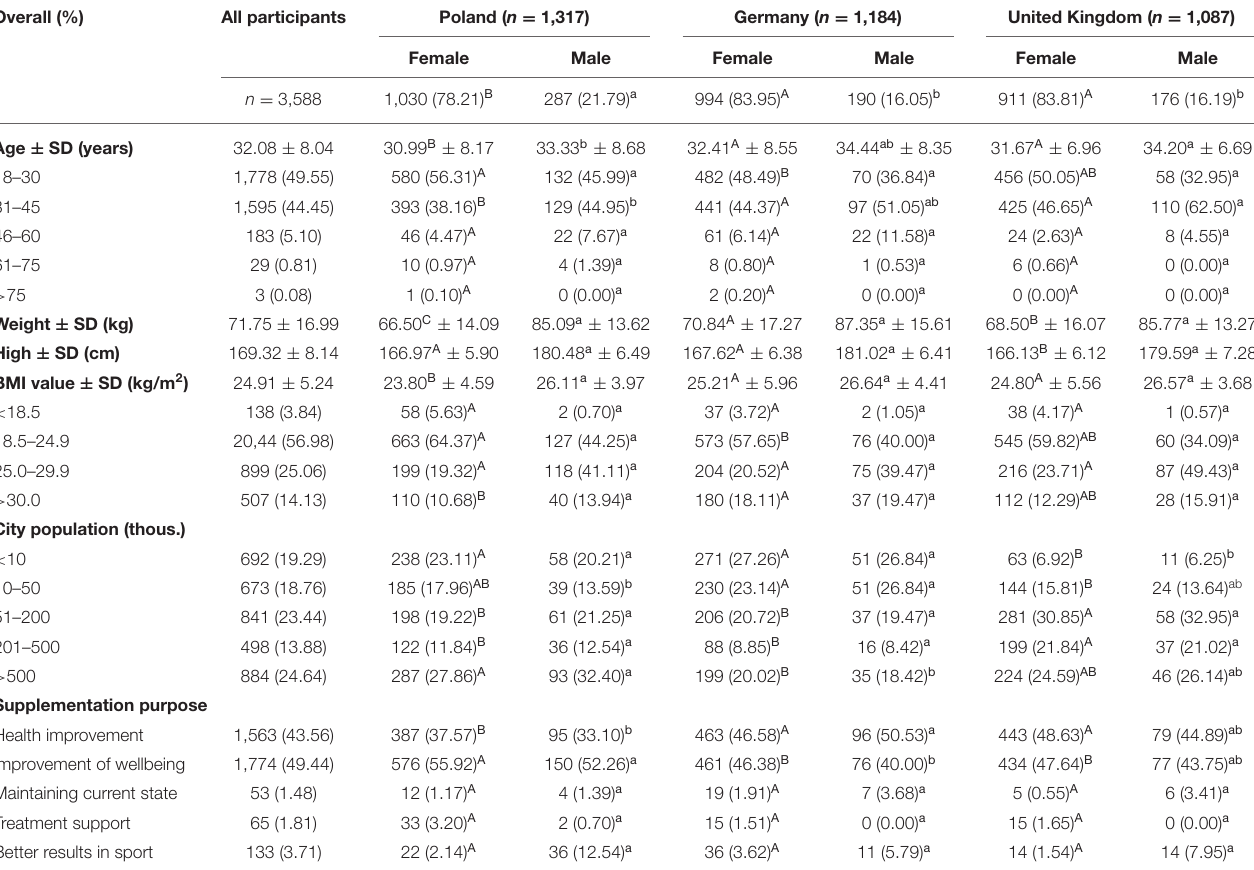
ABC Values with different letters in the same row are significantly different at p < 0.05 in the female group (Kruskal–Wallis test). abc Values with different letters in the same row are significantly different at p < 0.05 in the male group (Kruskal–Wallis test). BMI, body mass